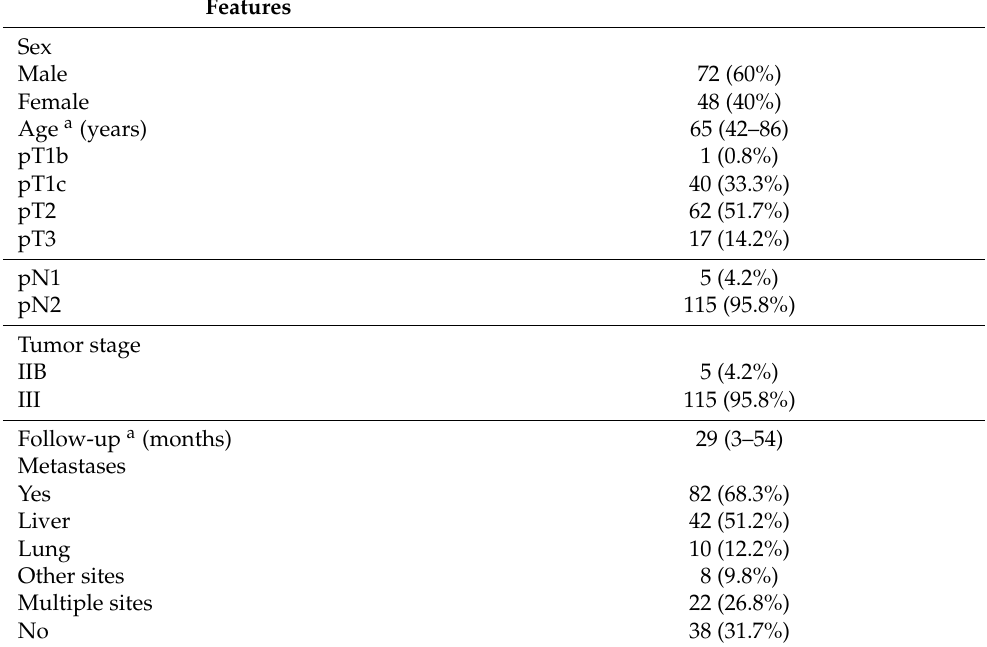
Table 1. Demographic and clinical features of the study population; data are number of cases (%), except where specified. T and N parameters and tumor stage are expressed according to the American Joint Committee on Cancer (AJCC) Cancer Staging Manual, 8th edition